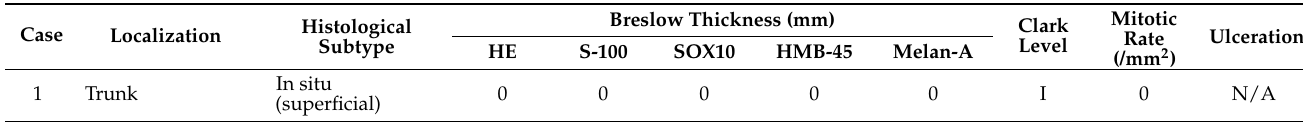
Table 3. Detailed clinicopathological characteristics of the evaluated